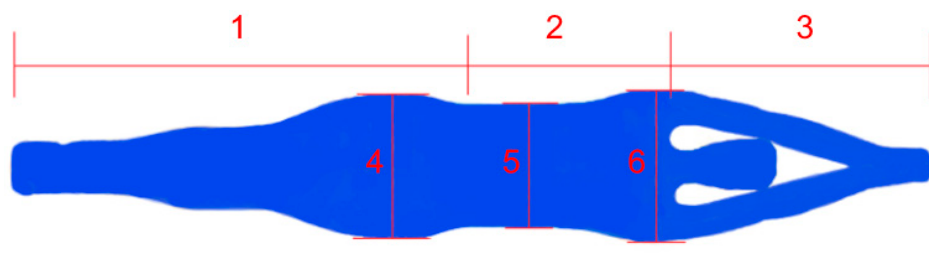
Figure 2. Anthropometric Features Measured on Female Top View Model. Table 1. Average Human Anthropometric Proportions (Percentage of Total Streamline Length) (From [23,24]).